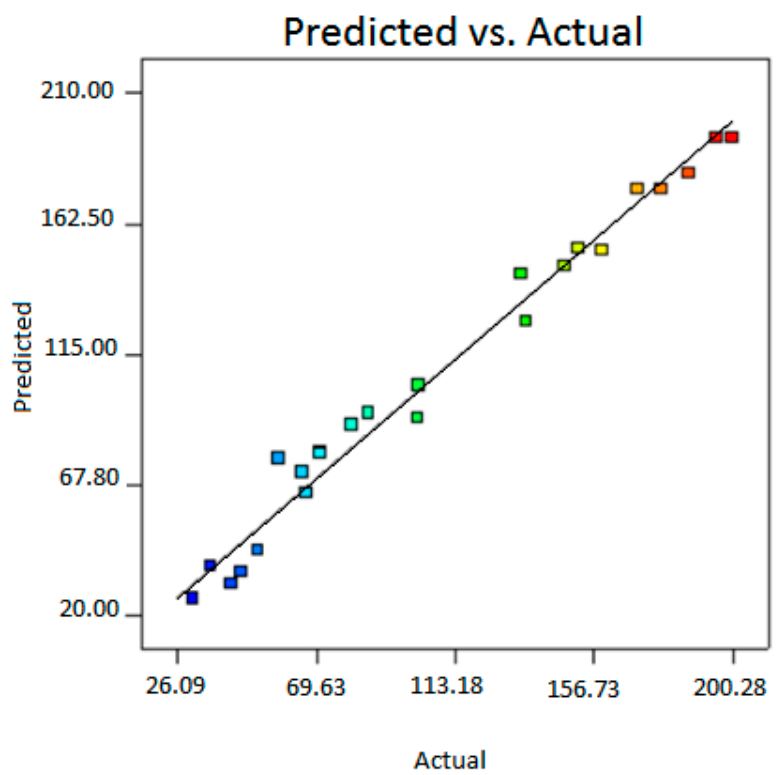
Figure 1. Correlation of actual and predicted values of lipase activity, from the response surface model. Dark blue cubes represent the lowest T1 lipase activity, while the red cubes represent the highest T1 lipase activity.